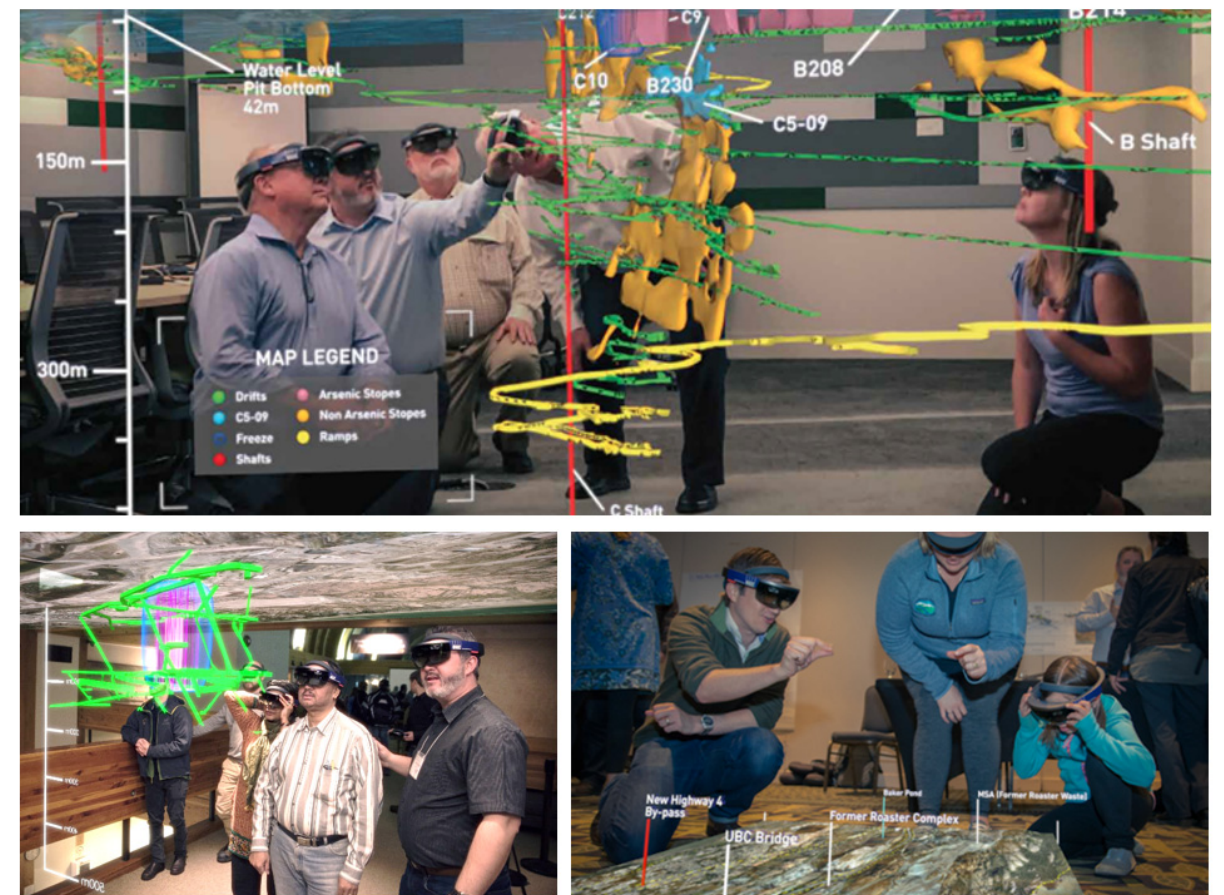
Figure 8. Example of sharing information for a mining remediation project using Microsoft’s HoloLens HMD. Giant Mine, Canada [17,54,55]. ( Top ) Five experts examining the complex 3D data at the office. The Arsenic stopes, ramps, shafts, tunnels and remedial measures are considered from all points of view. ( Left ) Visualizing the underground Arsenic chambers and the locations of remedial measures with community members. ( Right ) An engineer training two members of the community in the basic gestures when working with the HoloLens. The holographic view near the floor is a 3D orthophoto of the surface of Giant Mine, with some labels pinpointing points of interest (pictures courtesy of BGC).